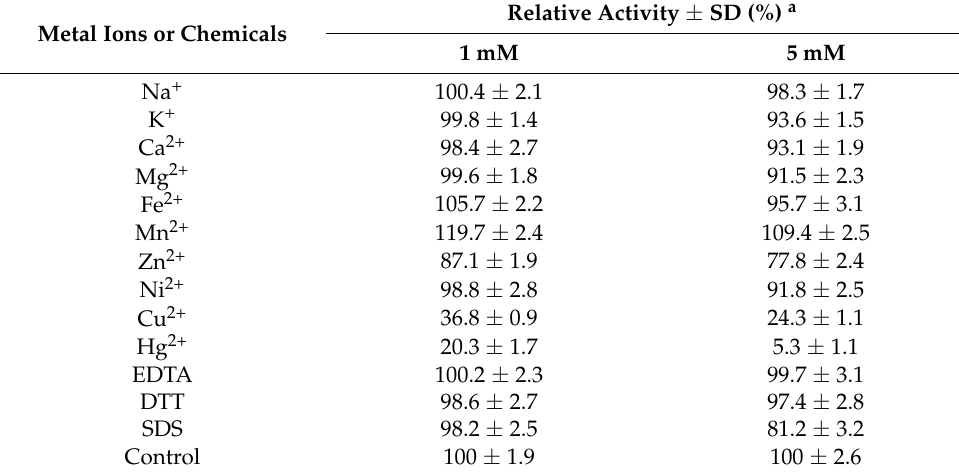
Table 3. Effects of metal ions and chemicals on the activity of